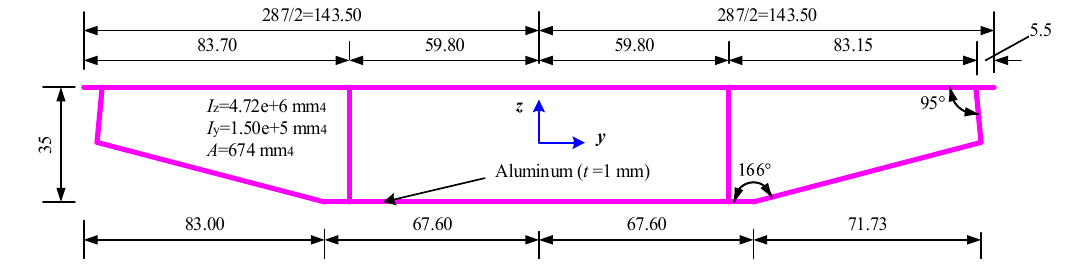
Figure 4. Simplified cross section of girder (units: mm).